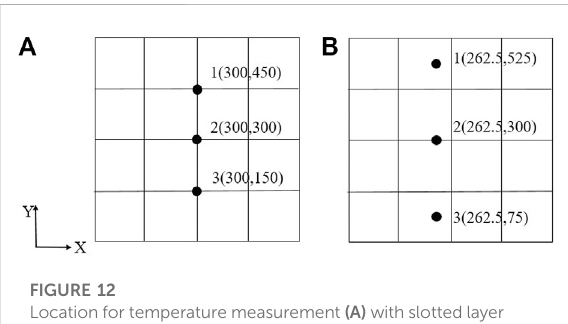
FIGURE 12 Location for temperature measurement (A) with slotted layer (B) without slotted layer.